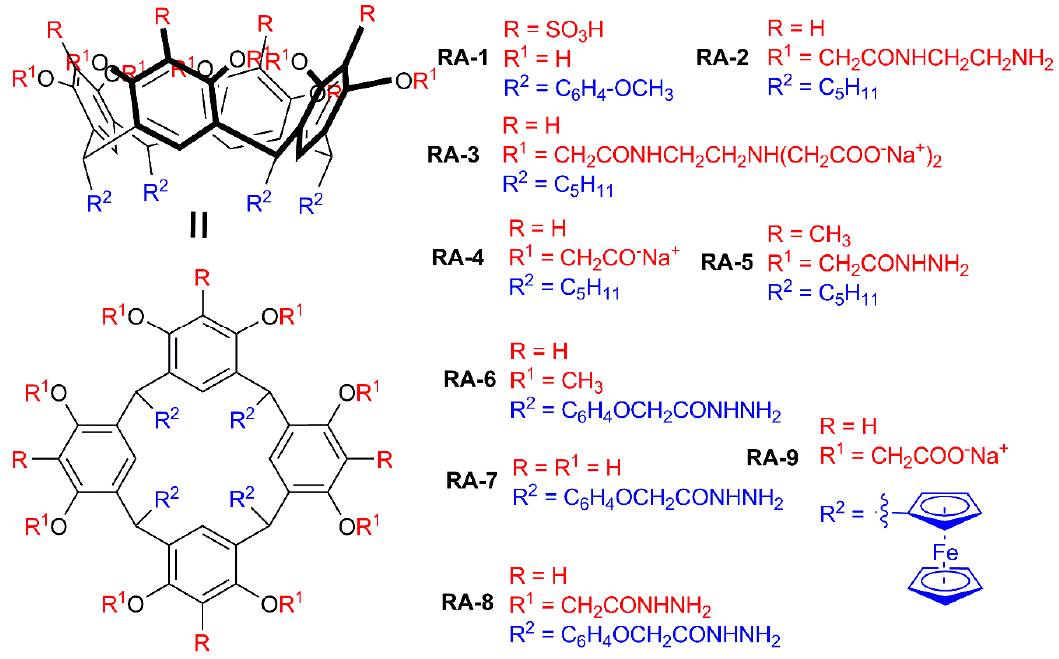
Figure 7. Structures of resorcin[4]arenes.